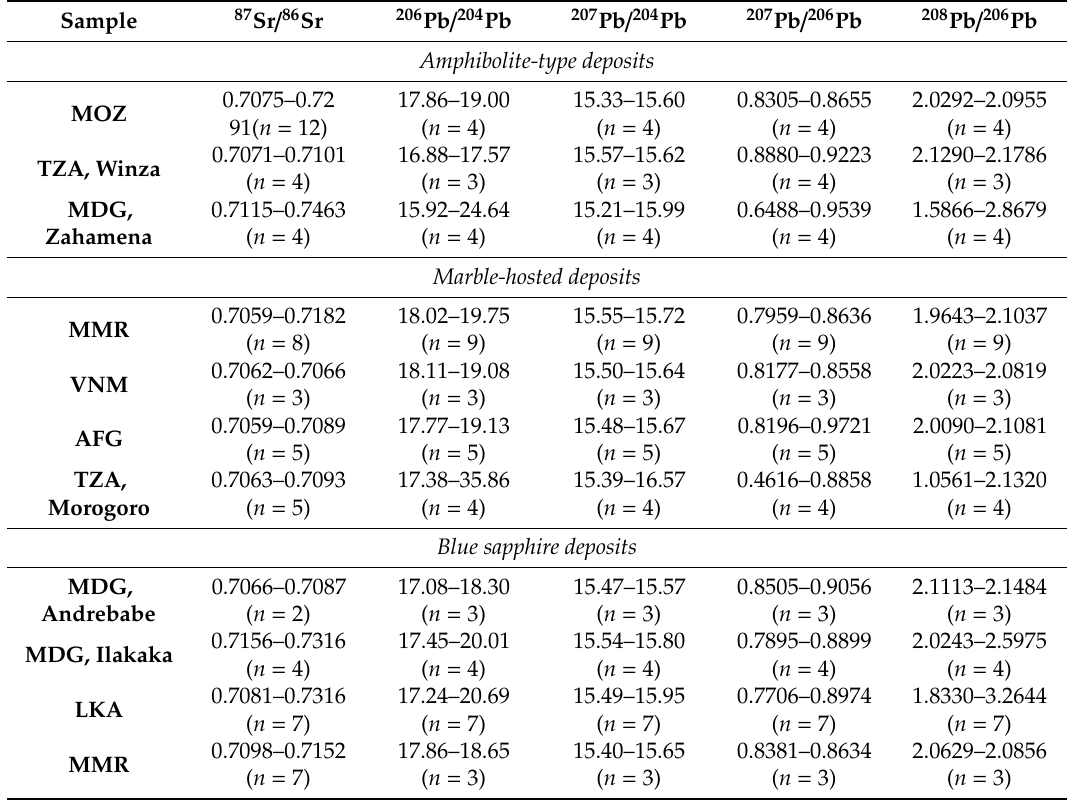
Table 4. Ranges in Sr and Pb isotopic ratios for the di ff erent localities analyzed in this study. Number of analyses in